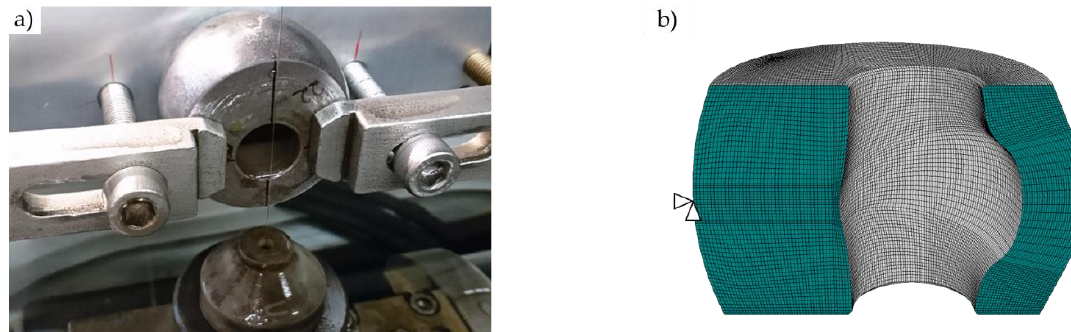
Figure 5. Application of the contour method for the analysis of the tangential RS component: ( a ) specimen clamping for WEDM and ( b ) FE model for RS evaluation.